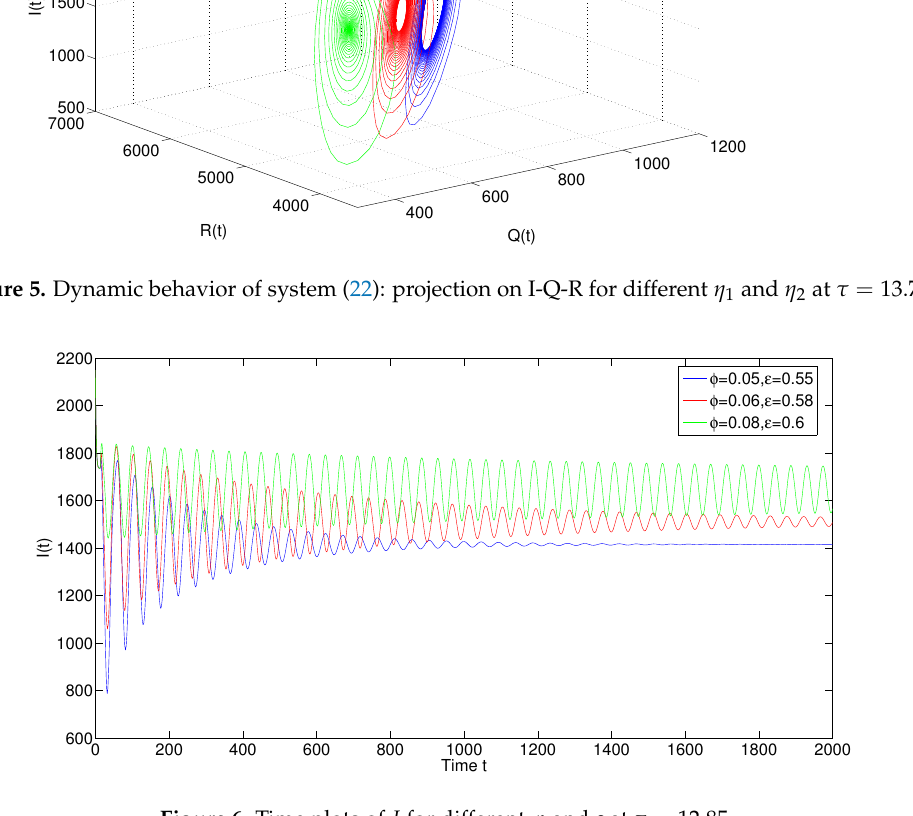
Figure 6. Time plots of I for different ϕ and ε at τ = 12.85.